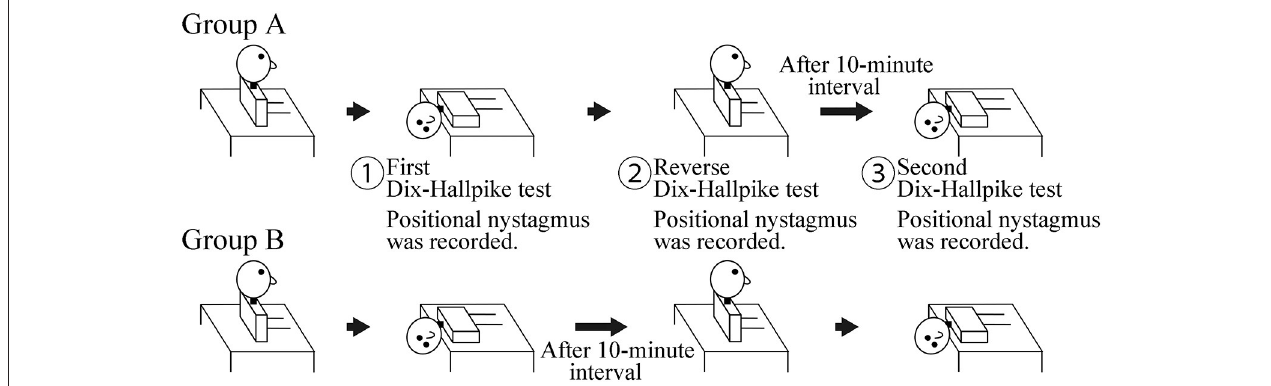
FIGURE 1 | Schematic of the study. Group A: a 10-min interval was set in the sitting position after the reverse Dix–Hallpike test. Group B: a 10-min interval was set in the supine position with the head turned to the affected side after the first Dix–Hallpike test. Positional nystagmus was recorded at the head positions shown by ‹ , › , and fi .